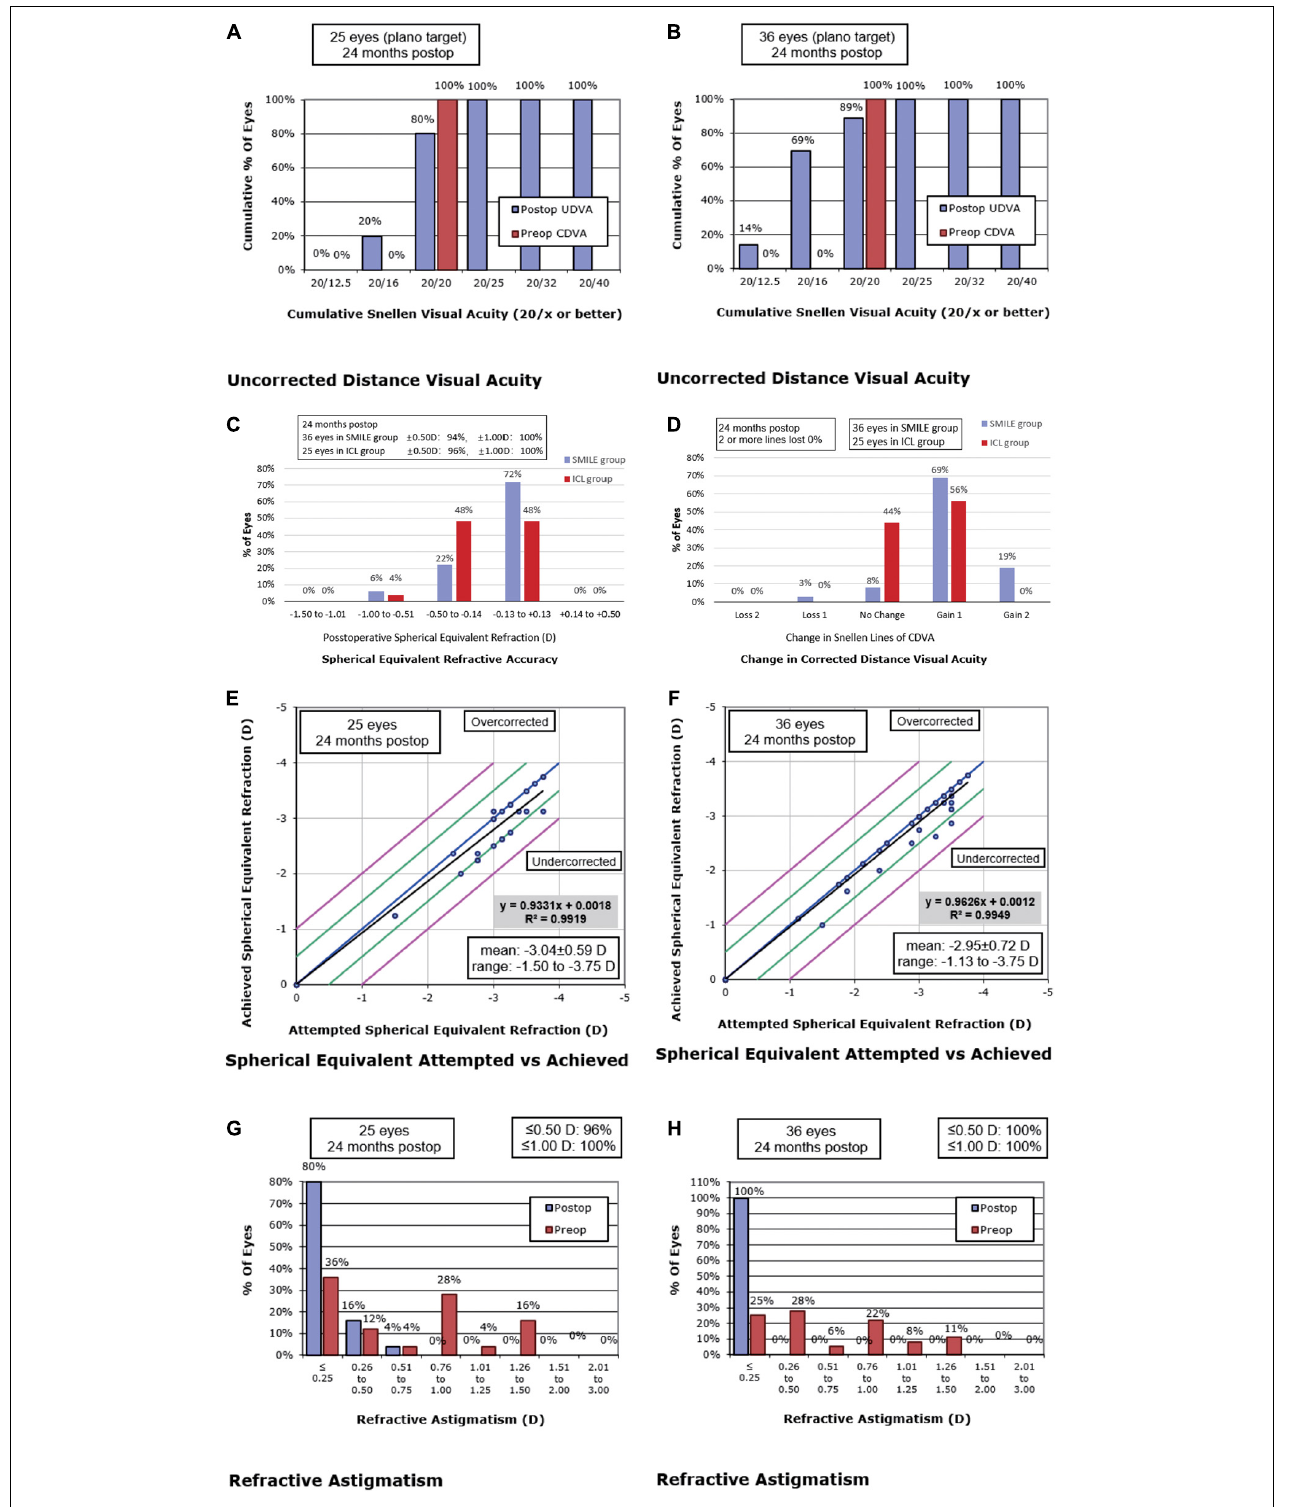
FIGURE 1 | Postoperative 2-year refractive outcomes after Implantable Collamer Lens (ICL) (A,C,E,G) and small incision lenticule extraction (SMILE) (B, D, F, H) for myopia. Cumulative uncorrected distance visual acuity (UDVA) after ICL (A) and SMILE (B) . (C) Spherical equivalent refraction after ICL and SMILE. (D) Changes in corrected distance visual acuity (CDVA) after ICL and SMILE. Attempted versus achieved spherical equivalent refraction after ICL (E) and SMILE (F) . Postoperative refractive astigmatism after ICL (G) and SMILE (H) . postop: postoperative; preop: preoperative.